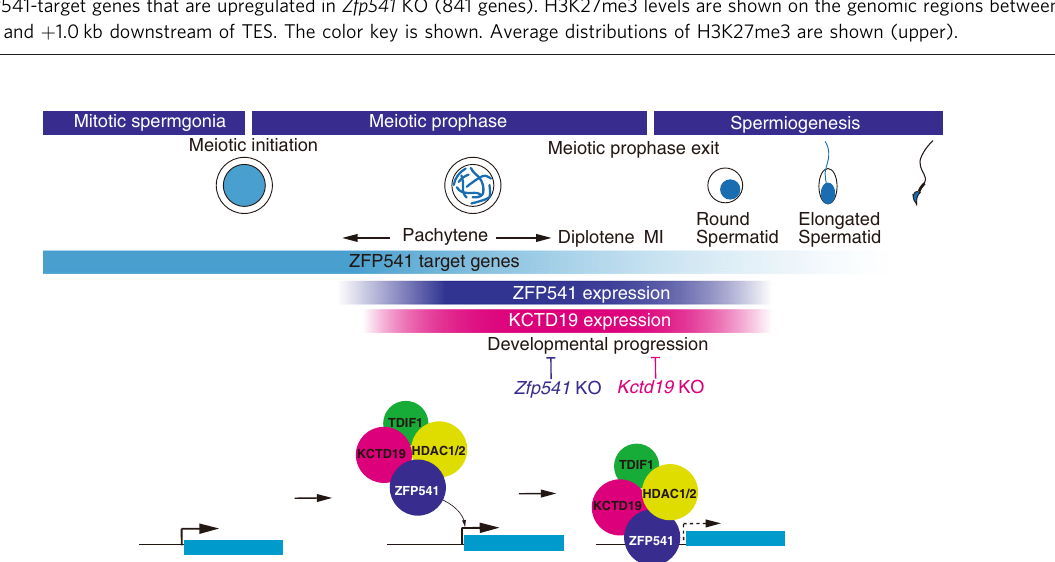
Fig. 8 ZFP541 binds to the gene promoter regions. a ZFP541-binding sites were classi fi ed by the genomic locations as indicated. b Genomic view of ZFP541 ChIP-seq and input DNA data over representative gene loci. Genomic coordinates were obtained from RefSeq. RefSeq IDs for mRNA isoforms are indicated. To specify testis-speci fi c TSS, RNA-seq of the 5 ′ capped end of the mRNA (CAGE) in P10.5 testis are shown 38 . c Top 3 sequence motifs enriched in ZFP541 ChIP-seq with E -values. MEME-ChIP E -value estimates the expected number of motifs with similar features that one would fi nd in a similarly sized set of random sequences. d Venn diagram representing the overlap of ZFP541-bound genes (5921 nearest genes), downregulated (751 genes), and upregulated genes (1530 genes) in Zfp541 KO mice. e GO analysis of the ZFP541-bound genes that were upregulated in Zfp541 KO mice (841 genes) ( p < 1.0 × 10 − 6 ). Top 3 biological processes ranked by log ( p -value) are listed. The ZFP541-bound genes that were downregulated in Zfp541 KO (213 genes) showed no GO terms statistically enriched. See Supplementary Data 3 for a complete gene list of the GO analyses. We used the standard parameters to detect over-represented GO terms for biological function, giving Fisher ′ s exact p -values. f Expression levels (RPKM) of the ZFP541-bound genes that were upregulated in Zfp541 KO spermatocytes (841 genes) are shown by box-whisker plot (whiskers indicate min and max. Bounds of box indicate 25th and 75th percentiles quantile with median). Thy-SG: Thy + spermatogonia, cKIT-SG: cKIT + spermatogonia, PS: pachytene spermatocytes, RS: round spermatid. g Heatmaps showing the hierarchical relationship among the clusters of the ZFP541-bound genes that were upregulated in Zfp541 KO spermatocytes across pseudotime of spermatogenesis. Expressions of the genes were assessed by reanalyzing scRNA-seq data of spermatogenic cells as described in Fig. 5e 29 . Pseudotime (left to right) corresponds to the developmental trajectory of spermatogenesis (undifferentiated spermatogonia to round spermatids). The cluster number is indicated on the right. See Supplementary Data 4 for the complete gene list of clusters 1 – 6. h Heat map of H3K27me3 levels on the ZFP541-target genes that are upregulated in Zfp541 KO (841 genes). H3K27me3 levels are shown on the genomic regions between − 1.0 kb upstream of TSS and + 1.0 kb downstream of TES. The color key is shown. Average distributions of H3K27me3 are shown (upper).